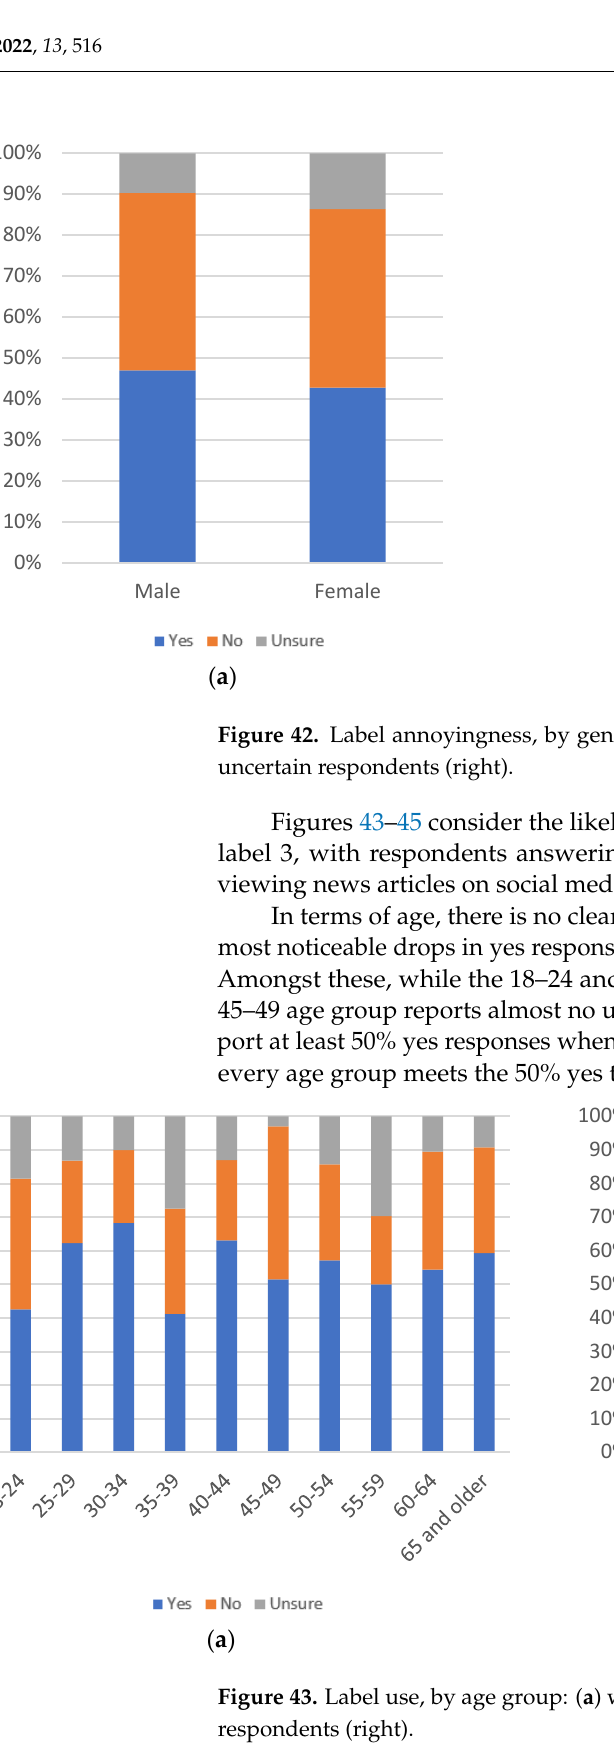
( b ) Figure 44. Label use, by education level: ( a ) with uncertain respondents (left) and ( b ) without un- certain respondents (right).